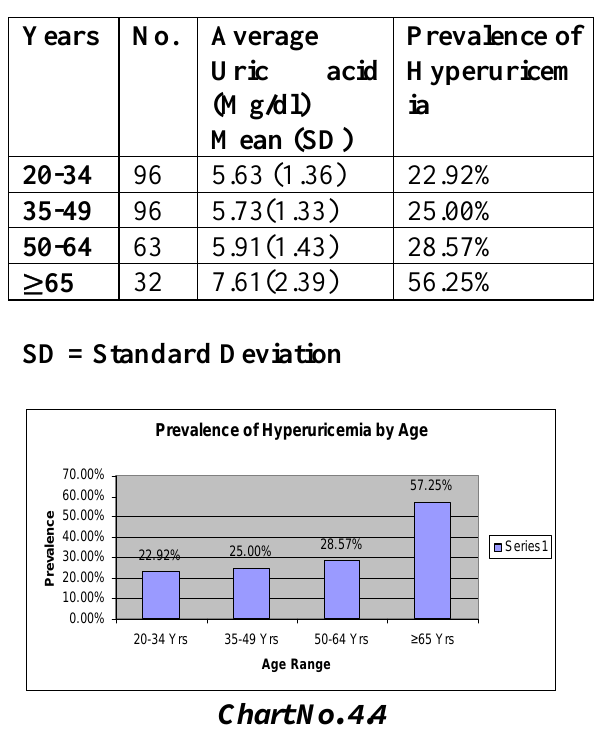
Table No. 4.4 Prevalence of Hyperuricemia